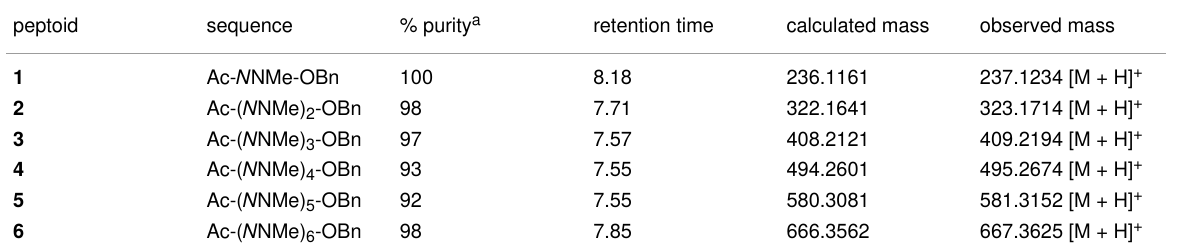
Table 1: Structures, purity, retention time, and calculated and observed masses for peptoids 1 – 6 . peptoid